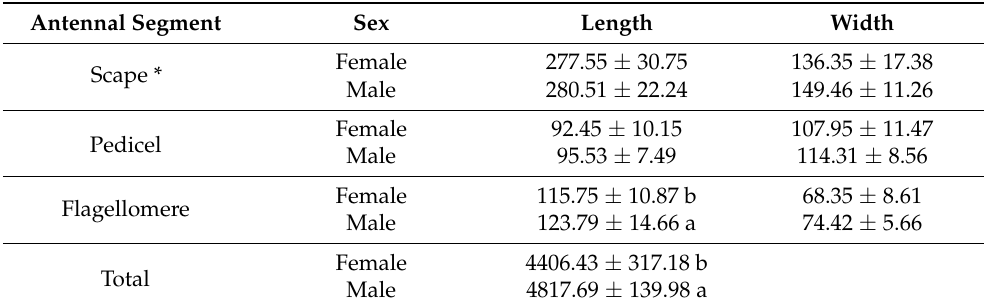
Table 1. Mean size of the antennal segments in female and male Coeloides qinlingensis .